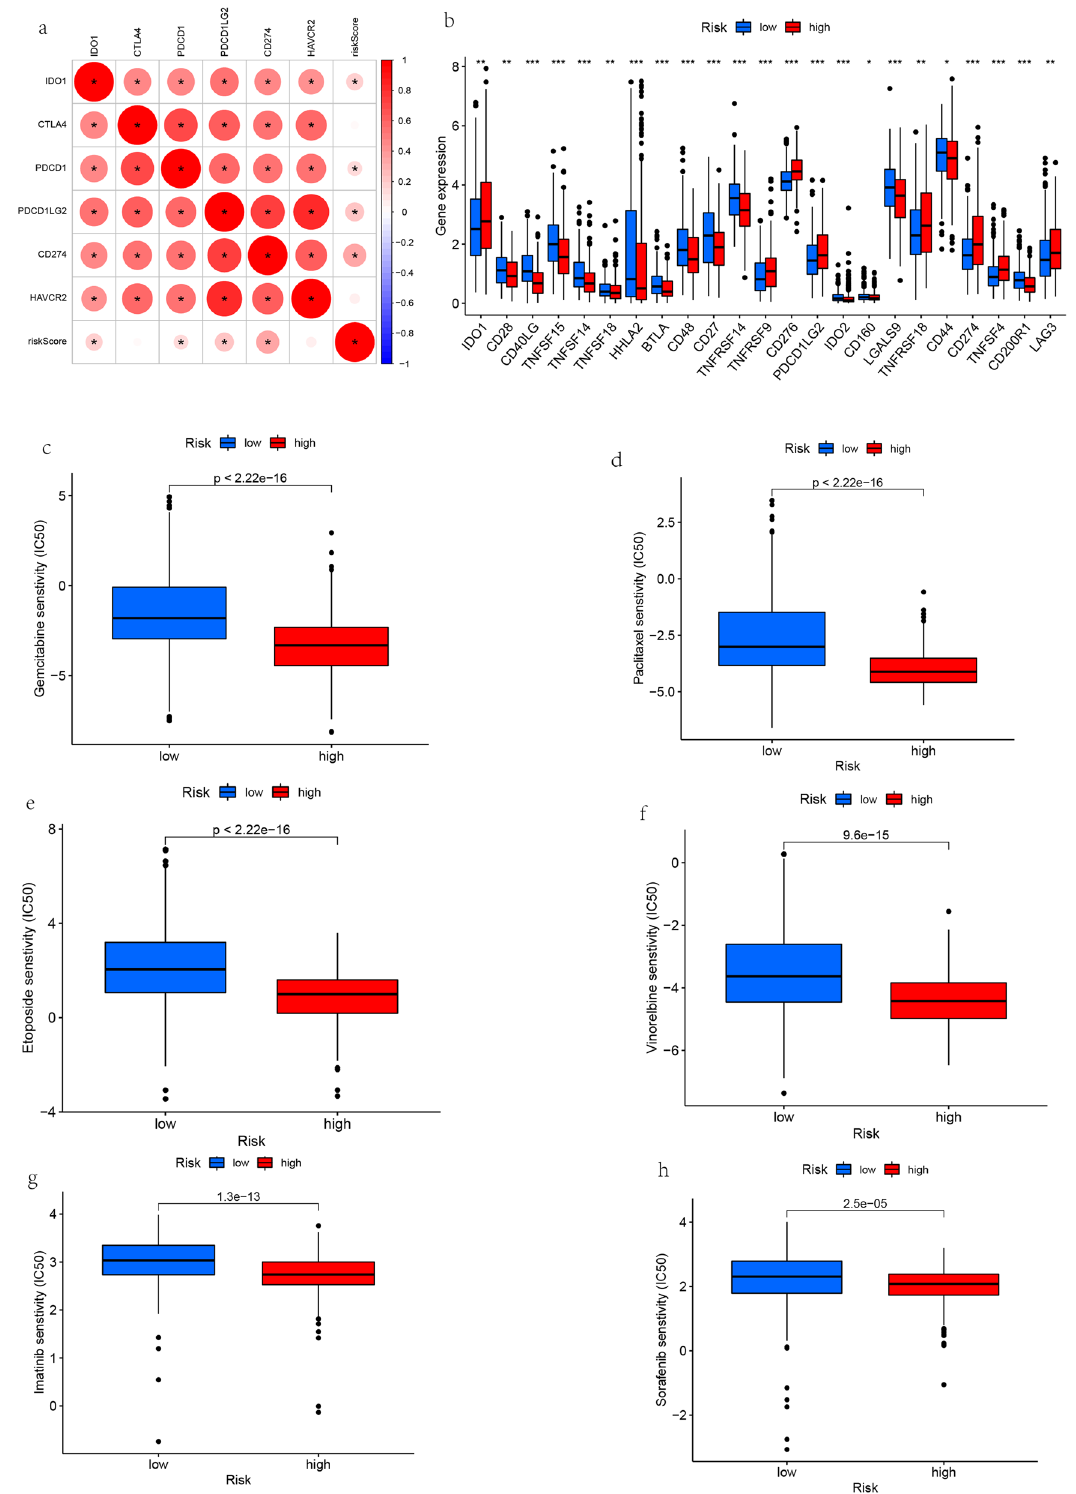
Figure 11. Difference analysis of immune checkpoints and screening of sensitive drugs. ( a ) Correlation between risk score and immune checkpoint. ( b ) Immune checkpoint difference analysis. ( c – h ) Risk score and anticancer drug sensitivity